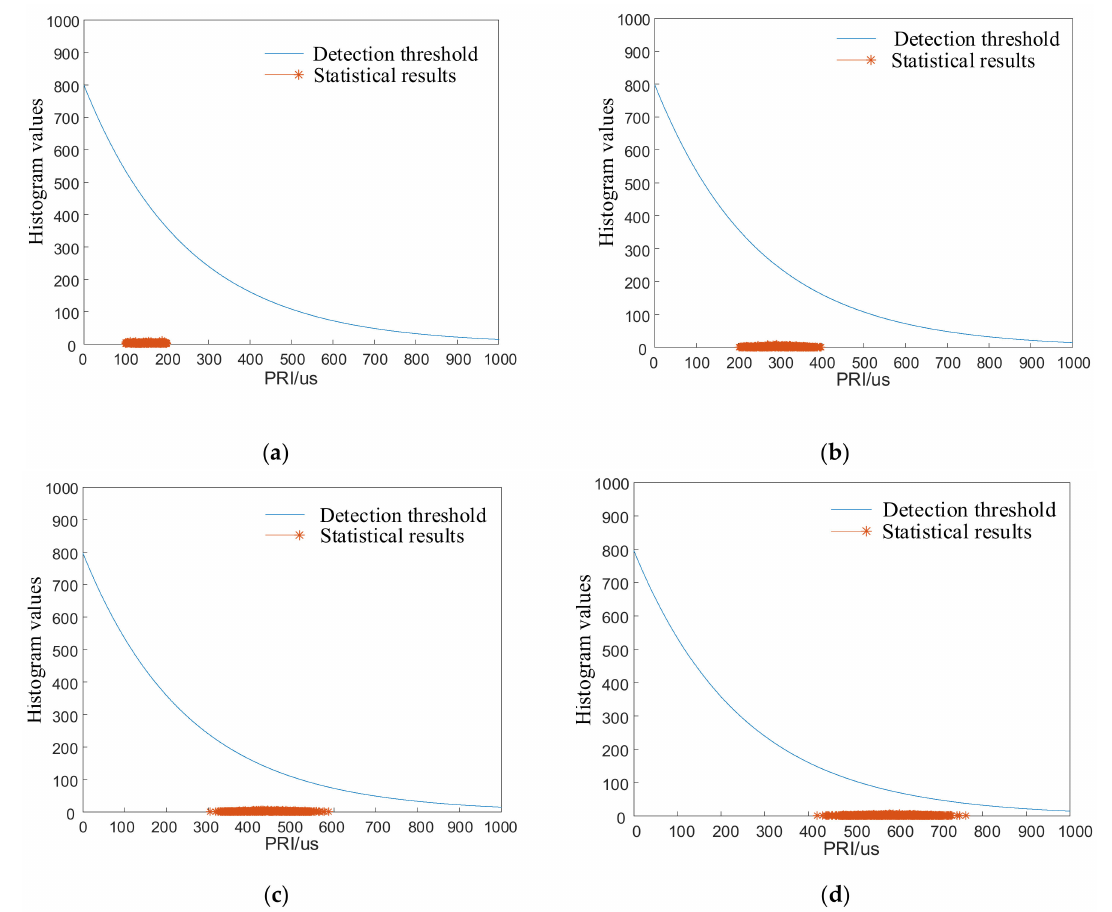
Figure 6. Histogram of first- and multi-order TOA differences in simulation case 4. ( a ) The histogram of the first-order TOA difference in signal PRI values uniformly distributed in an interval; ( b ) the histogram of the second-order TOA difference in signal PRI values uniformly distributed in an interval; ( c ) the histogram of the third-order TOA difference in signal PRI values uniformly distributed in an interval; ( d ) the histogram of the fourth-order TOA difference in signal PRI values uniformly distributed in an